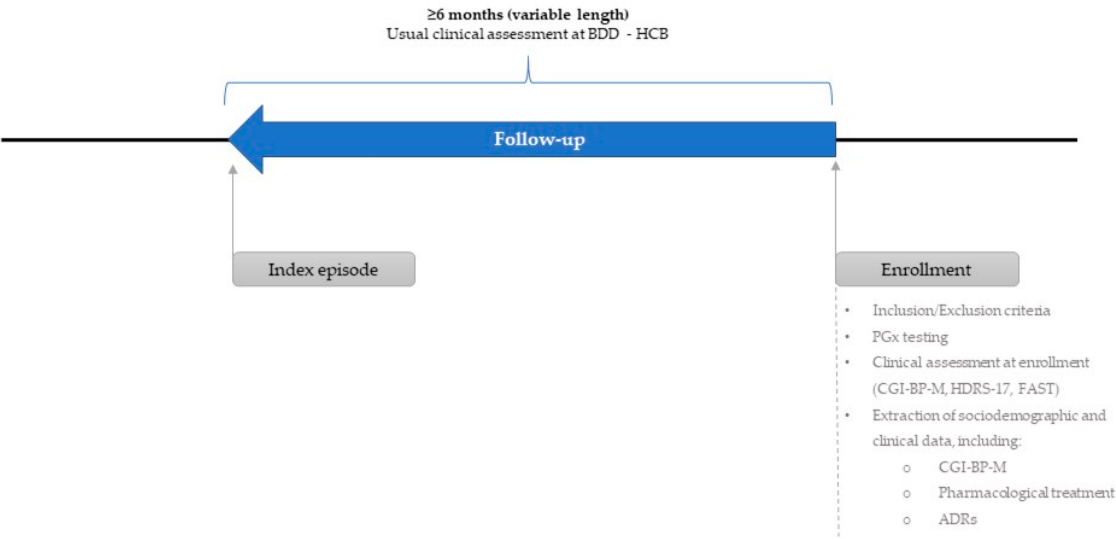
Figure 1. Schematic of the PGx ‐ BP study procedures. BDD–HCB: Bipolar and Depressive Disorders Unit Program of the Psychiatry Service of the Hospital Clínic de Barcelona; CGI ‐ BP ‐ M: Clinical Global Impression for Bipolar Disorder, Modified version; FAST: Functioning Assessment Short Test; HDRS ‐ 17: 17 ‐ Item Hamilton Depression Rating Scale; PGx: Pharmacogenetic.